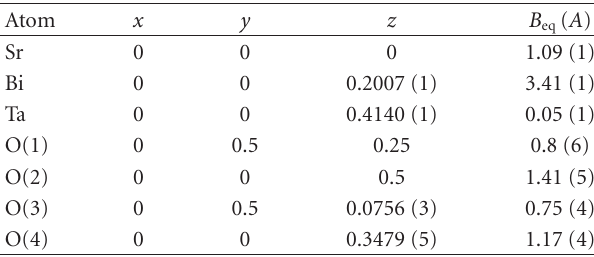
Table 2: Positional and thermal parameters of the paraelectric phase (I4/mmm) SrBi 2 Ta 2 O 9 at 1000K [25].